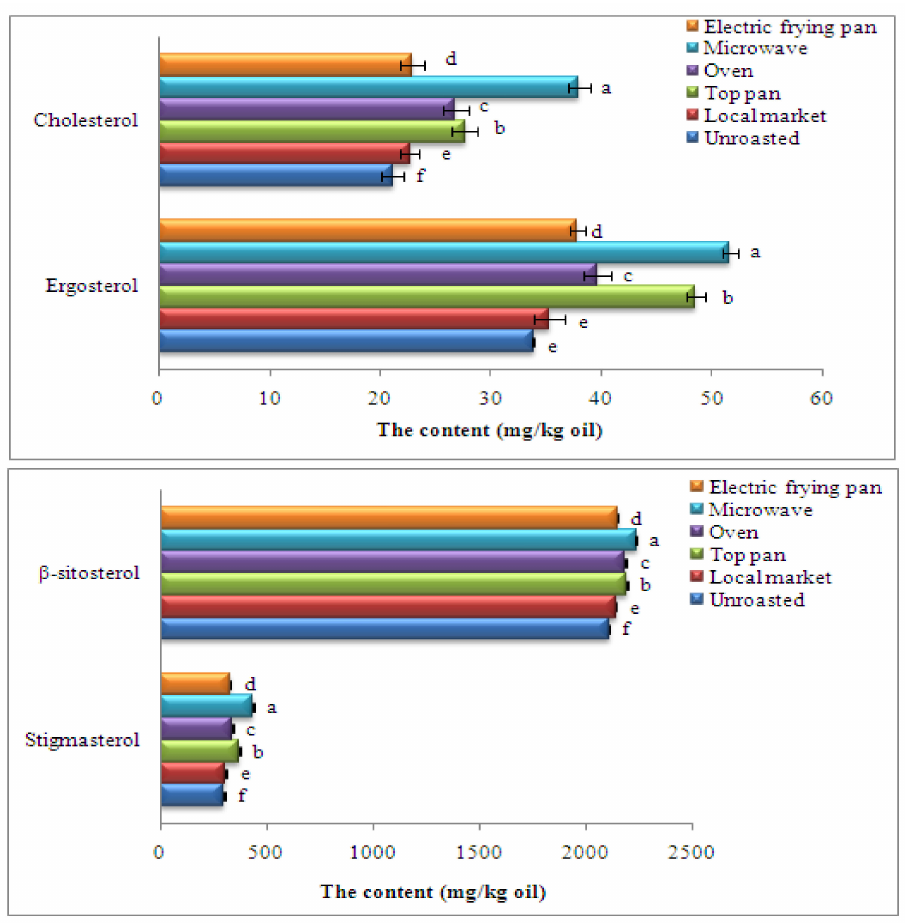
Figure 4. Phytosterol composition of oils recovered from sesame seeds roasted with different methods. Significant variations at p ≤ 0.05 are indicated by vertical bars with SD (n = 3) and different letters on the bars of every